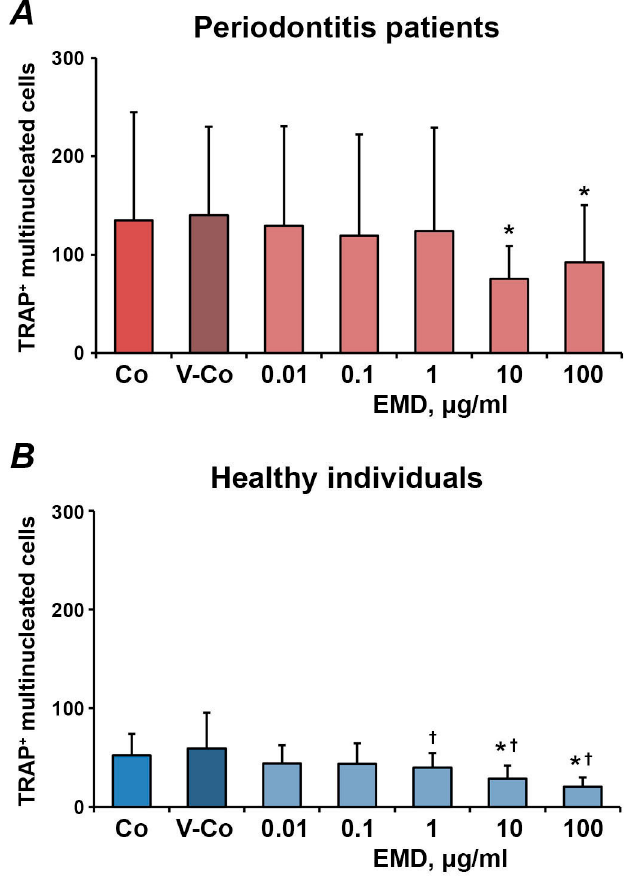
Figure 5. The effect of EMD on the formation of osteoclast-like cells from PBMCs after trans-endothelial migration. HUVECs were seeded on Transwell inserts with 8 µM pore size and pre-activated with 25 nM TNF- α and 10 U/mL IL-1 β . Freshly isolated PBMCs were applied into Transwell inserts, transmigrated PBMCs were collected for 3 h and used for osteoclast-formation assay in the presence of different EMD concentrations. Cells treated with 0.01% of acetic acid were used as vehicle control (V-Co). Cells without EMD treatment were used as control (Co). Y -axis represents the number of TRAP + multinucleated cells. Data are presented as mean ± SD of 7 periodontitis patients ( A ) and 8 healthy individuals ( B ). *-significantly different compared to V-Co; †-significantly different compared to Co.